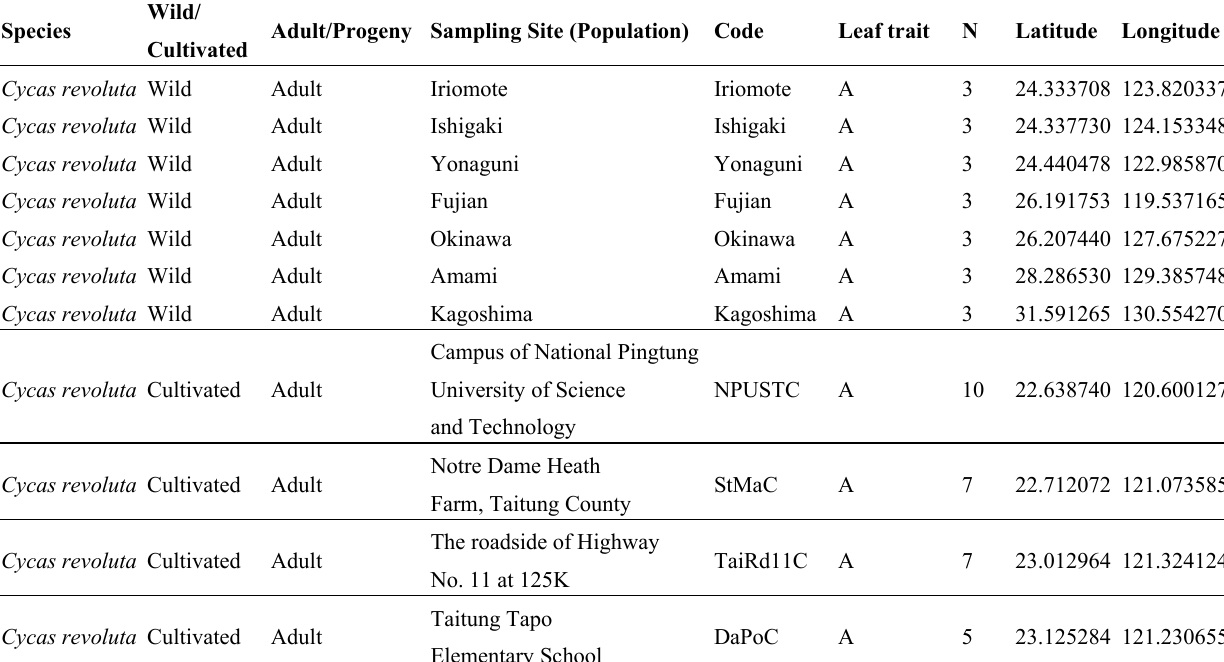
Table A1. Information of sampling sites of Cycas revoluta and C. taitungensis